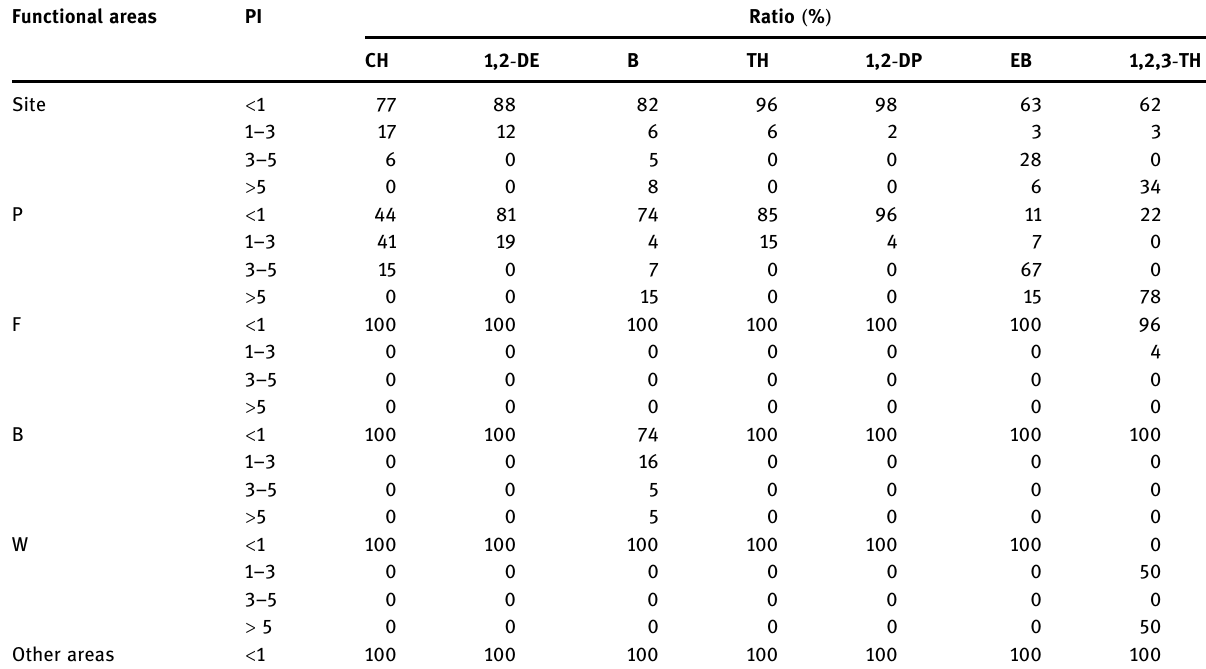
Table 2: Class distribution of PI for VOCs in soil of chemical site Functional